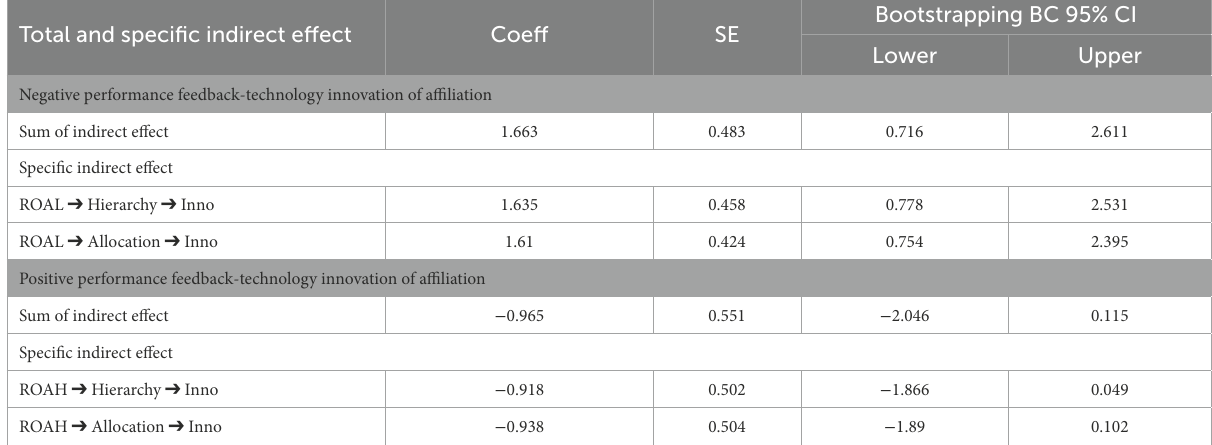
TABLE 3 Results of the bootstrap test for the mediating effect of the parent’s